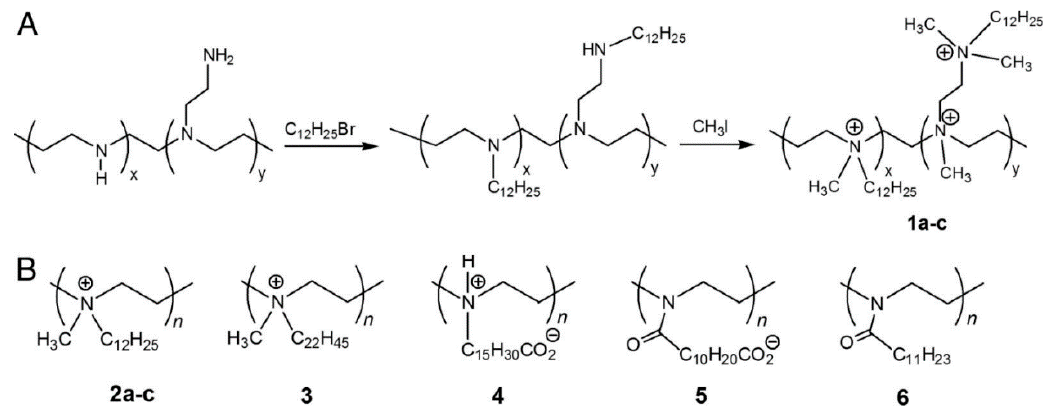
Figure 7. ( A ) Polymerization of 1 a – c polymers and ( B ) chemical structures of polymers 2 a–c . 3, 4,